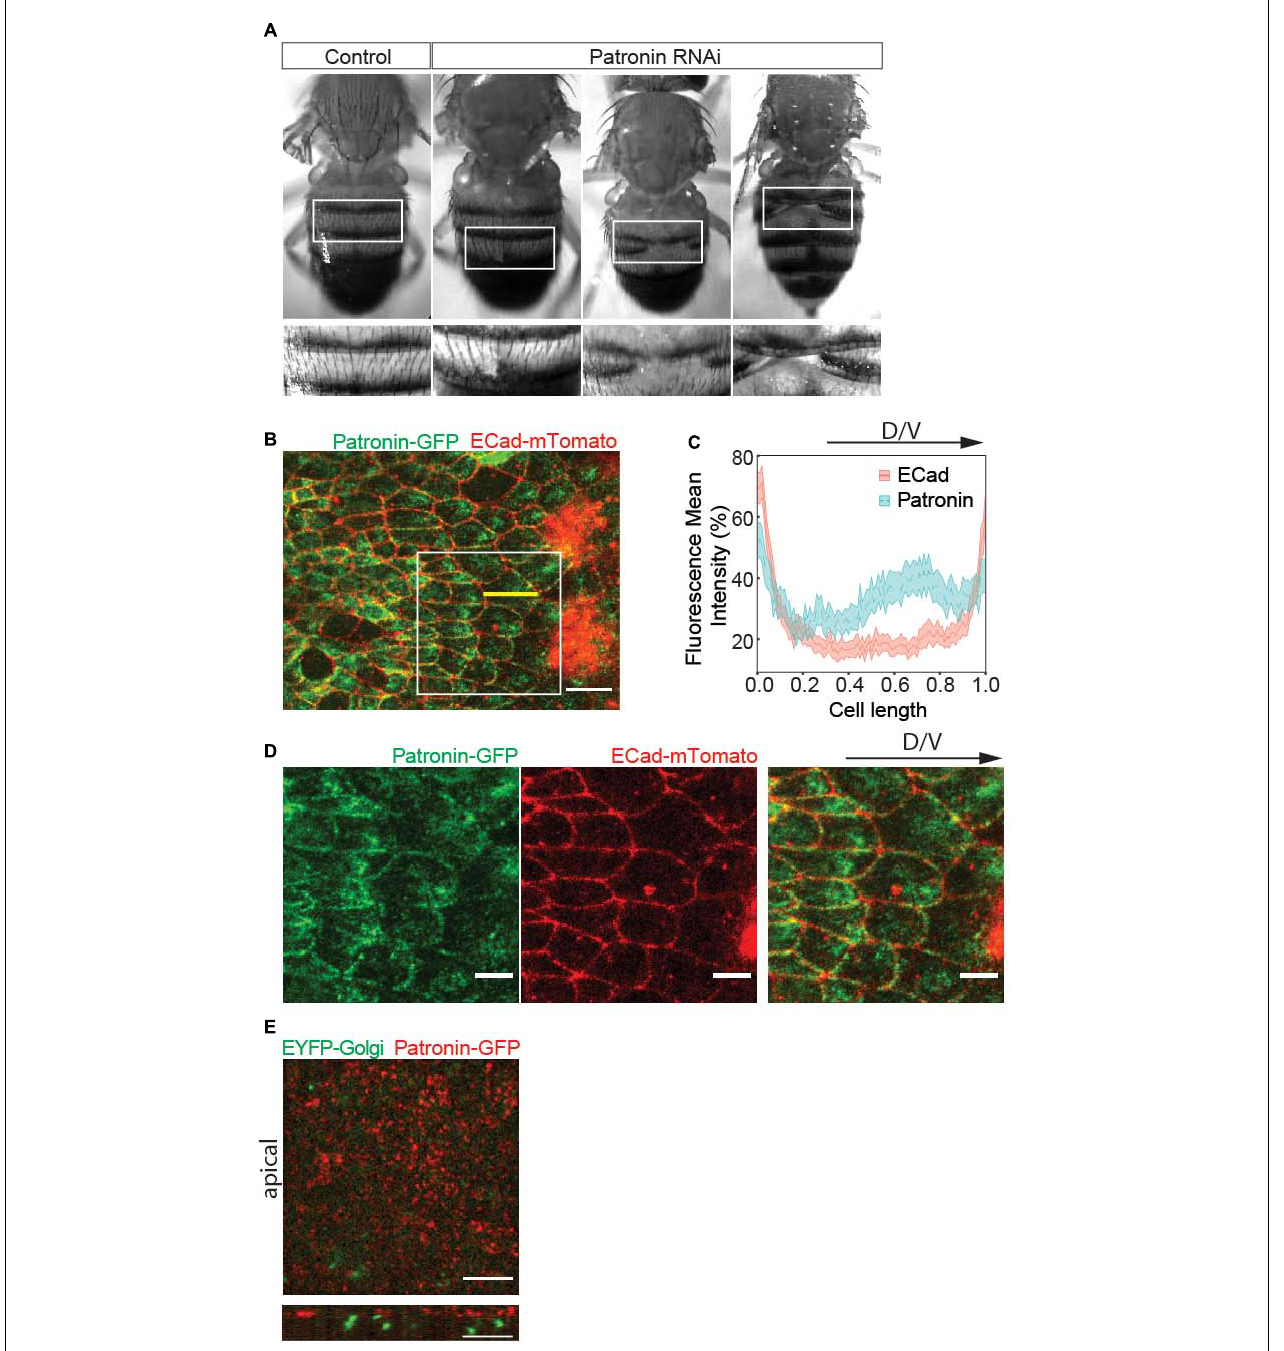
FIGURE 1 | Patronin is required for abdominal morphogenesis. (A) Adult abdomens overexpressing patronin RNAi exhibit clefts. Insets: closeups of adult abdomens in boxed regions. The number of affected individuals in control ( Patronin RNAi VDRC108927 line only ) was 0/116 adults and in overexpressing patronin RNAi was 13/100 adults. Unpaired t -test Welch’s correction: p = 0.0083 (**) for overexpressing patronin RNAi compared to the control. (B) A representative live fluorescence image of 27–28 h after puparium formation (APF) abdomen showing histoblast expressing Patronin-GFP (green) and the adherens junction marker ECad-mTomato (red). Scale bar = 10 µ m. (C) Quantification of fluorescence intensities of Ecad-mTomato (red) and Patronin-GFP (green) signals along the longitudinal axis of cells. The intensities along the long axis of each cell [shown with a yellow line in panel (B) ] were normalized to the cell length of 1 and averaged. The regression analysis includes cell fixed effects and standard errors are clustered by cell (see Supplementary Tables 1A,B ). The shaded area around the mean indicates the 95% confidence interval. Number of cells ( n ) = 92 and pupae ( N ) = 3. (D) Insets from panel (B) showing Patronin-GFP (green, left), ECad-mTomato (red, middle), and merged (right). Scale bar = 5 µ m. (E) Live fluorescence images of EYFP-Golgi marker and Patronin-RFP. Top view (above) and cross-section (below). Developmental stage (B–E) : 27–28 h APF. Scale bar, 5 µ m.